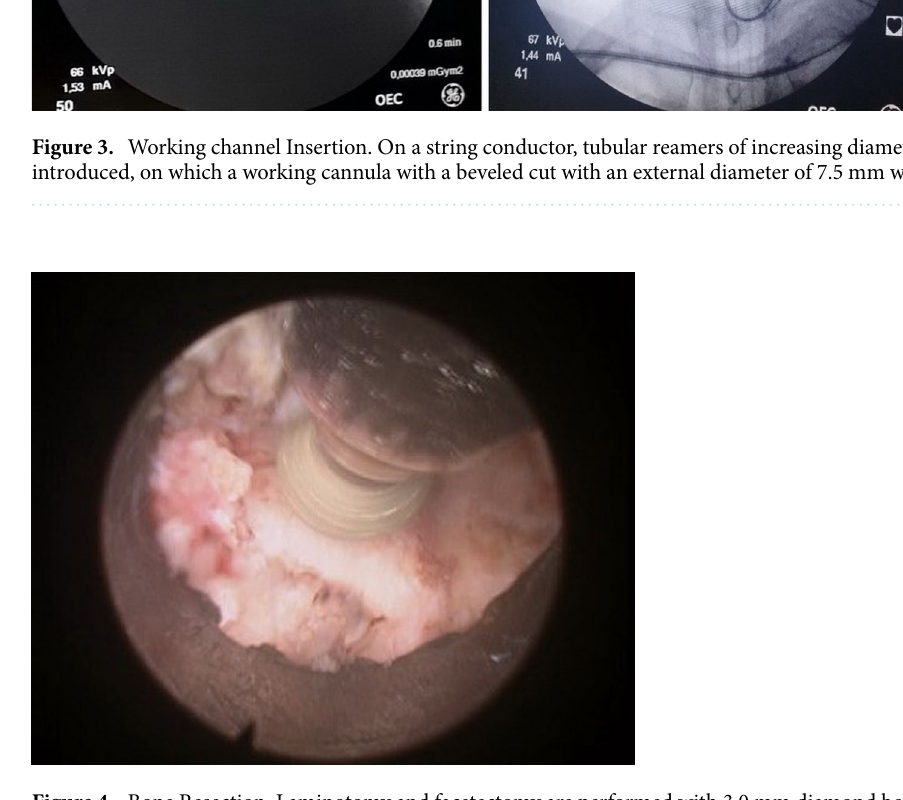
Figure 4. Bone Resection. Laminotomy and facetectomy are performed with 3.0 mm diamond boron, from “V-point” to the